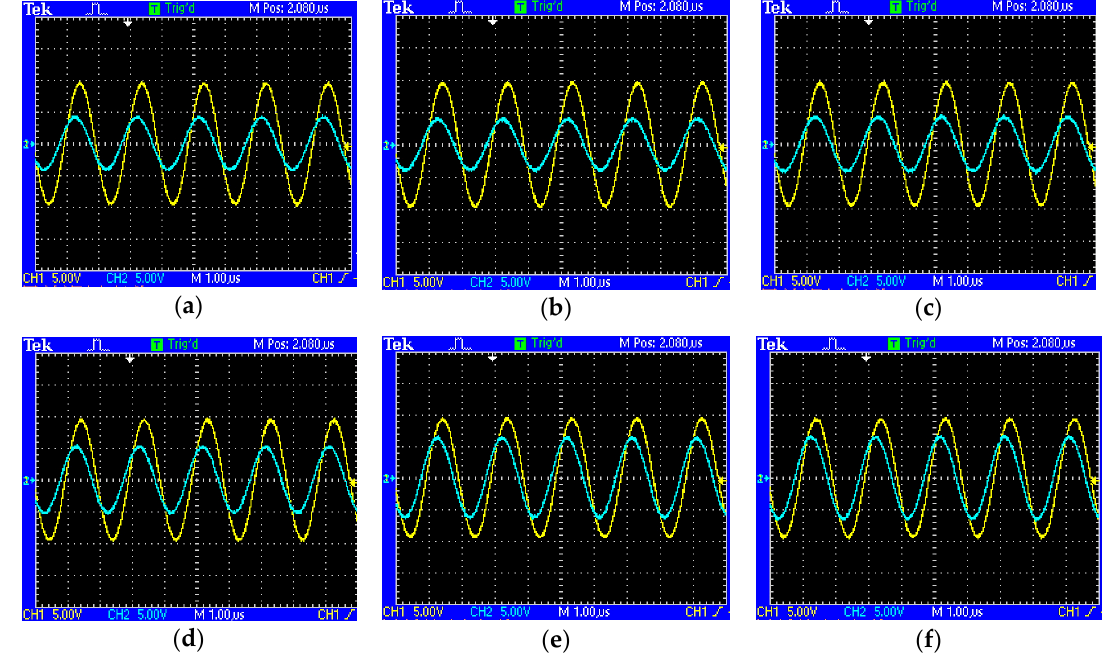
Figure 24. Input (yellow) and output (blue) coil-to-coil voltages for the optimized model with 5- Ω load: ( a ) α = 0°; ( b ) α = 15°; ( c ) α = 30°; ( d ) α = 45°; ( e ) α = 60°; ( f ) α = 85°.